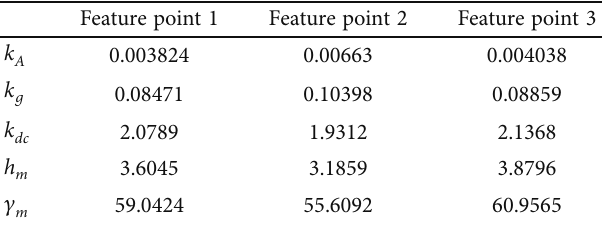
ffiffiffiffiffiffiffiffiffiffiffiffiffiffiffiffiffiffiffiffiffiffiffiffiffiffiffi